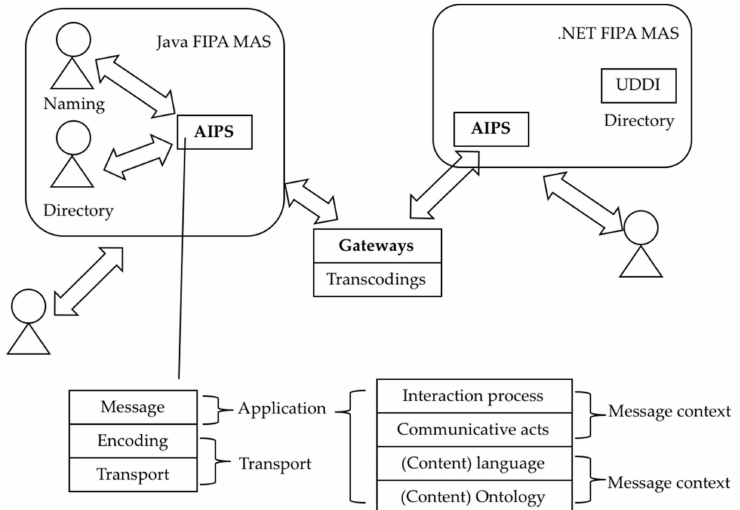
Figure 7. Foundation for the Intelligent Physical Agent (FIPA) specifies multi-agent systems (MAS) interaction using specifications for an Agent Interaction Protocol Suite (AIPS) and MAS platform